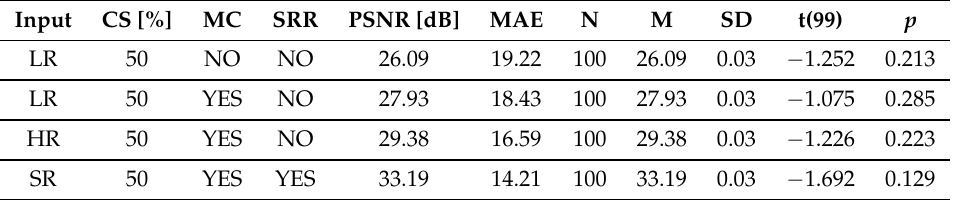
Table 6. The performance of different reconstruction algorithms for in-vivo brain image (Figure 6) (MC—motion correction, HR—upscaling using Non-Rigid Multi-Modal 3D Medical Image Registration Based Foveated Modality Independent Neighbourhood Descriptor).